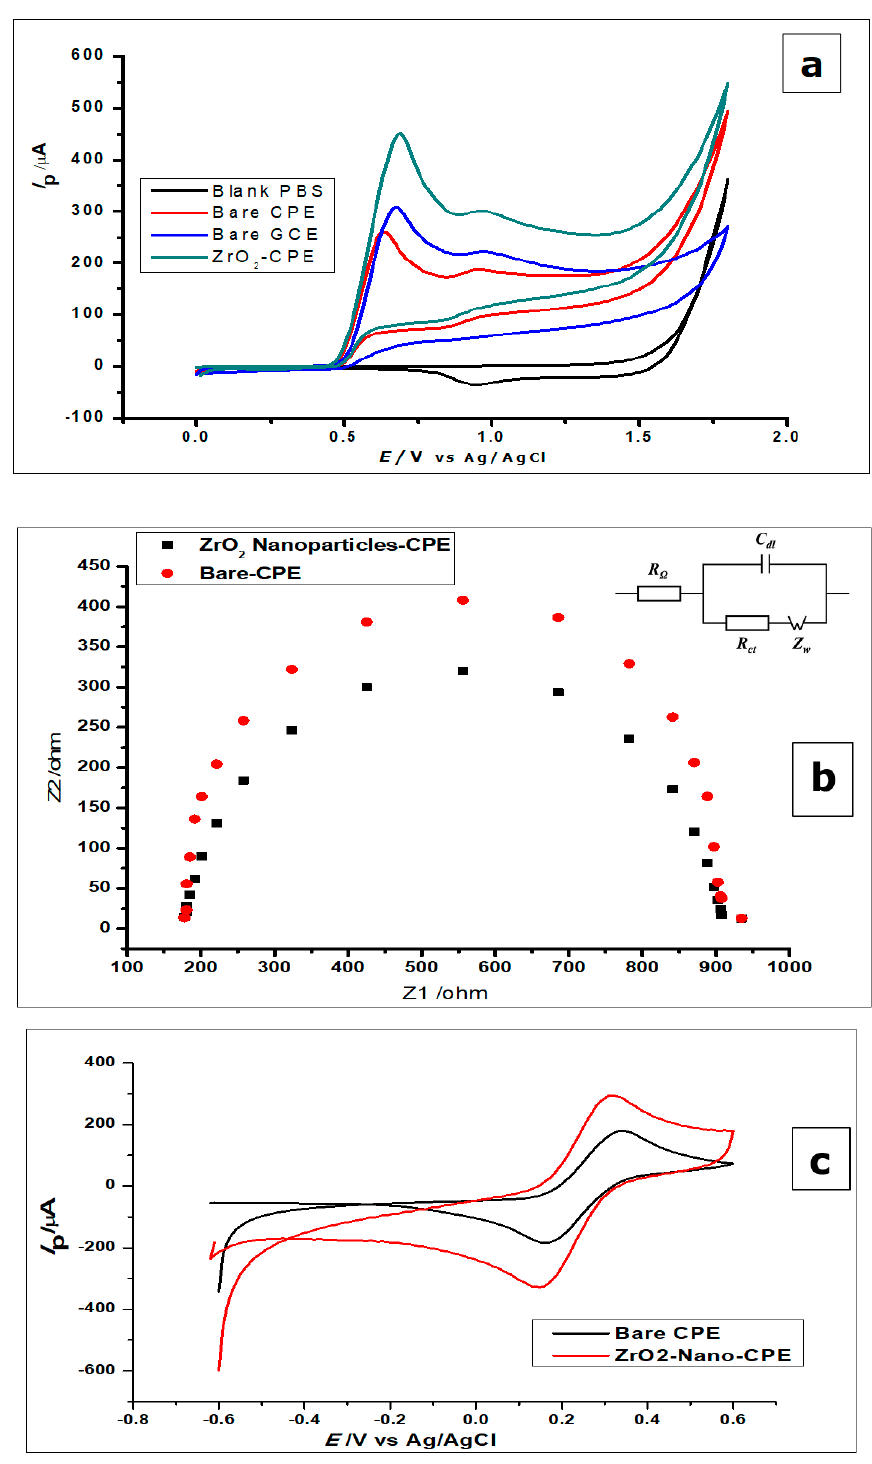
Figure 5. ( a ) Cyclic voltammograms of 1 × 10 − 2 mol L − 1 GA at ZrO 2 nanoparticles-modified CPE, bare CPE and bare glassy carbon electrode (GCE) in 0.1 mol L − 1 phosphate buffer of pH 2.0 at a scan rate of 100 mVs − 1 ( b ) Nyquist plot representing the EIS measurement of 5mmol L − 1 using the bare CPE and ZrO 2 nanoparticles (inset) The equivalent circuit showing resistors and capacitor ( c ) The cyclic voltammograms of 1.0 × 10 − 3 mol L − [Fe(CN) 6 ] 3 − / 4 − redox solution, using bare CPE and ZrO 2 nanoparticles-modified CPE.